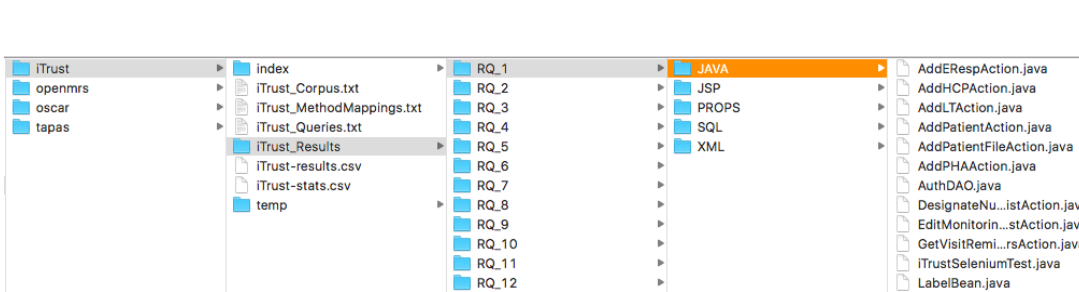
Figure 7: Folder structure of results obtained after the execution of the traceability algorithm for iTrust. Parent folder contains stats about the algorithm execution, corpus and query files, method mapping file and result summary file. Results folder contains subfolders for each requirement specified in the query file, containing the most related artefacts and source code lines for a given requirement.